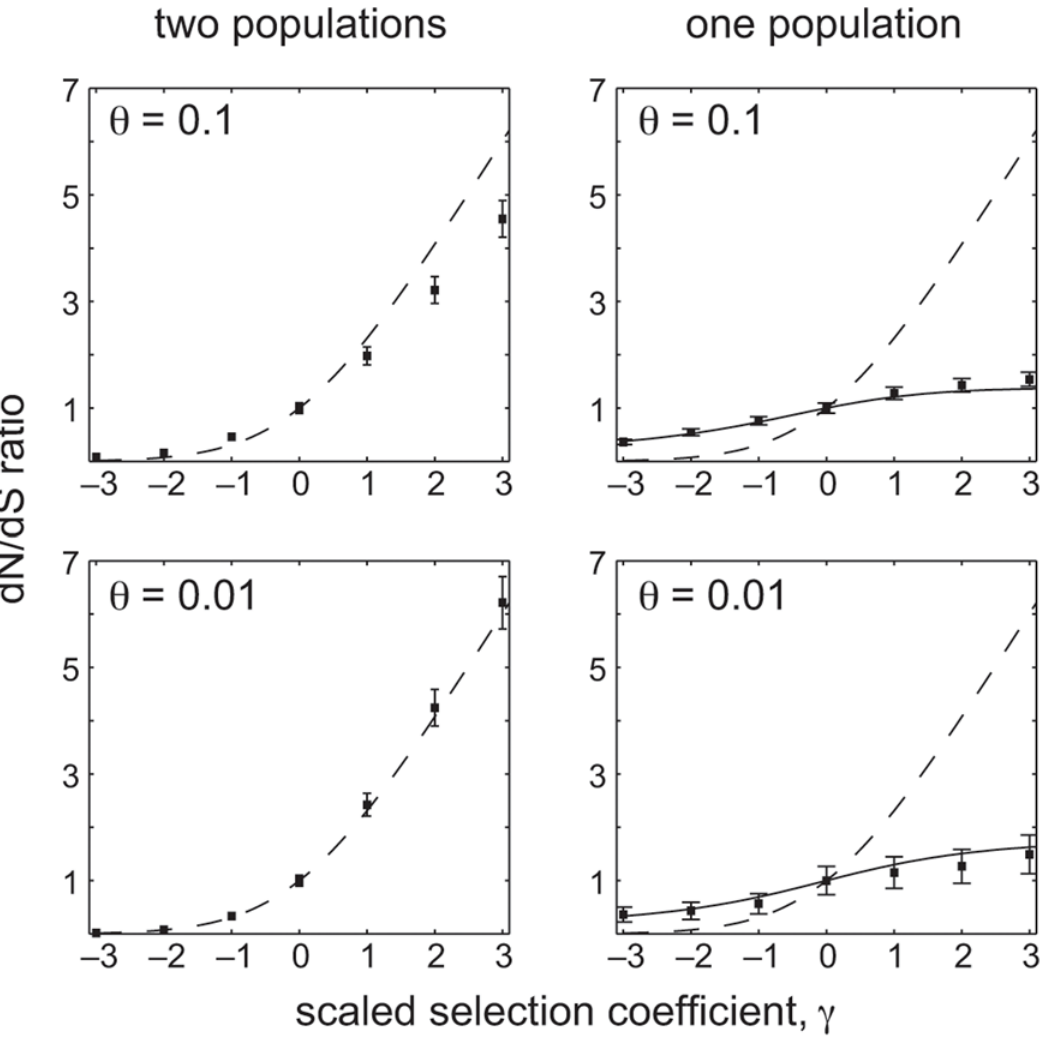
Figure 3. The relationship between the scaled selection coefficient, c , and the dN/dS ratio in simulated Wright-Fisher populations. Black squares show the mean 6 two standard errors of the observed dN/dS ratio. The predicted dN/dS ratios for divergent lineages are shown in dashed lines (Equation 2); the predicted dN/dS ratios for a single population are shown in solid lines (Equation 5). Left column corresponds to results for two independent populations; right column corresponds to results for a single population. Top panels show results for h =0.1; bottom panels show results for h =0.01. The simulations for two populations were performed at L =10 3 independent sites, and the simulations for a single population were performed at L =10 4 independent sites.